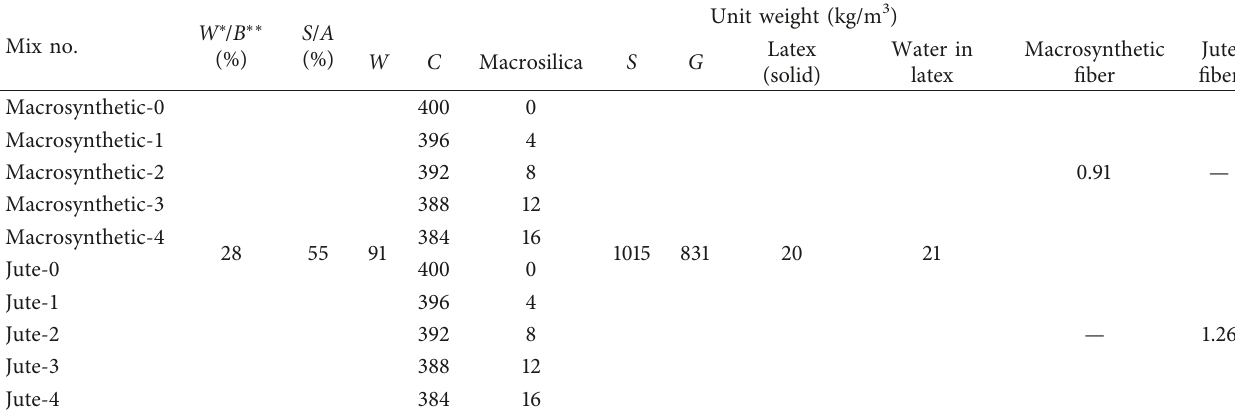
Figure 1: Geometry of fibers [16]. (a) Jute fiber. (b) Macrosynthetic Table 6: Mix proportions of LMFRCRSC for a pavement repair.